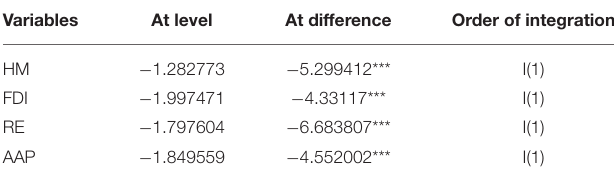
TABLE 1 | ADF unit root.